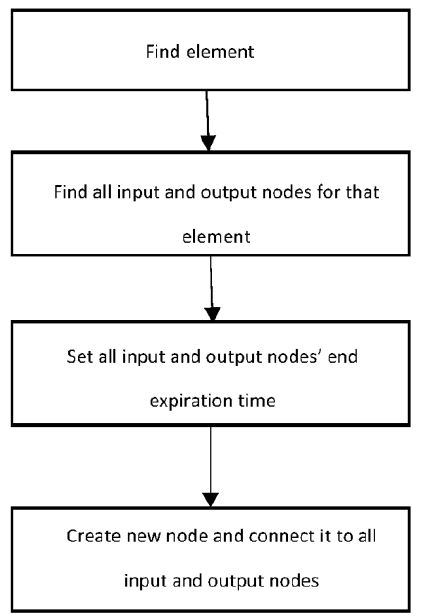
Figure 6. BDA for adding a new value (2nd approach).